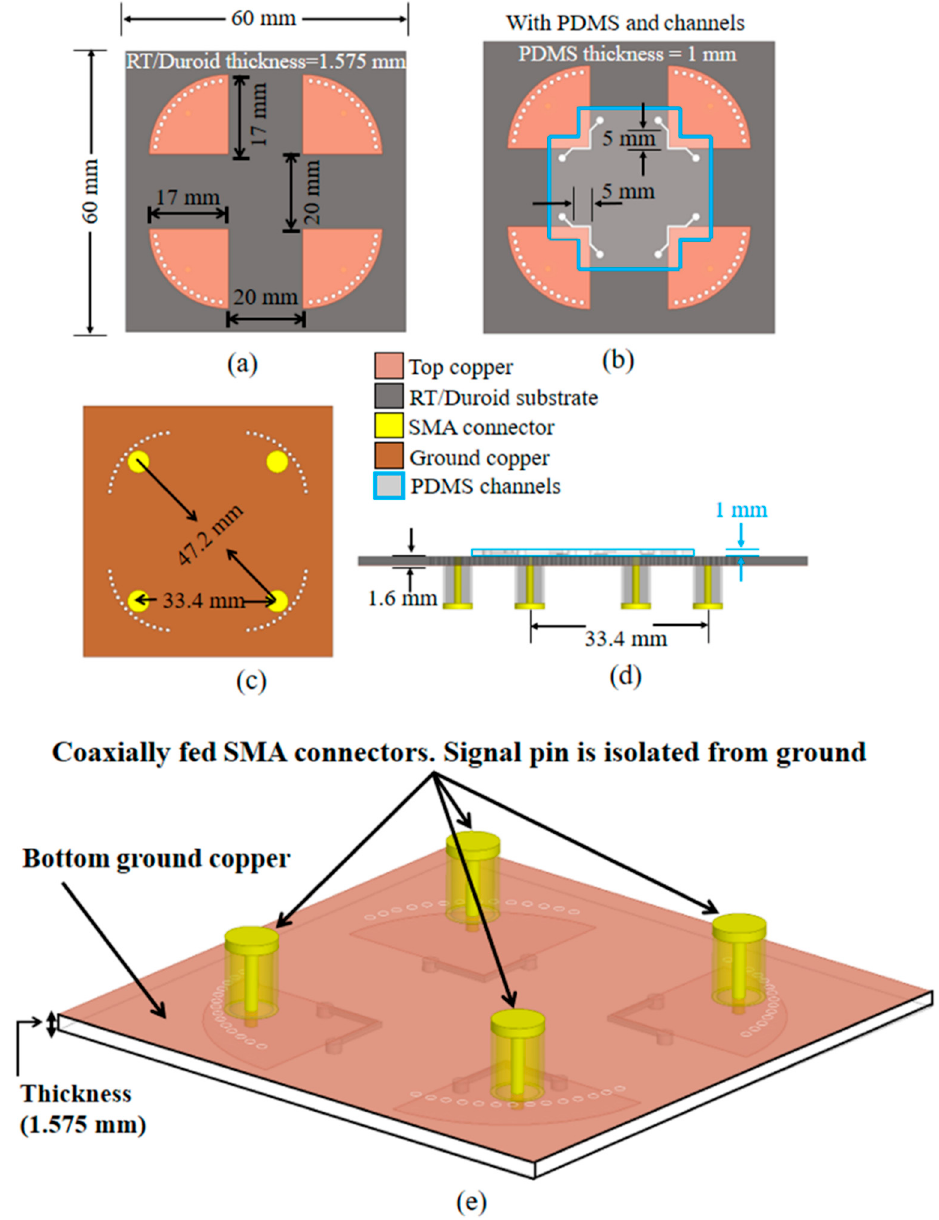
Figure 4. Proposed 4-port quarter mode substrate-integrated waveguide sensor design with physical dimensions: completed structure top view ( a ) without and ( b ) with microfluidic channels, ( c ) bottom view, ( d ) cross-sectional view, and ( e ) bottom view, angled.